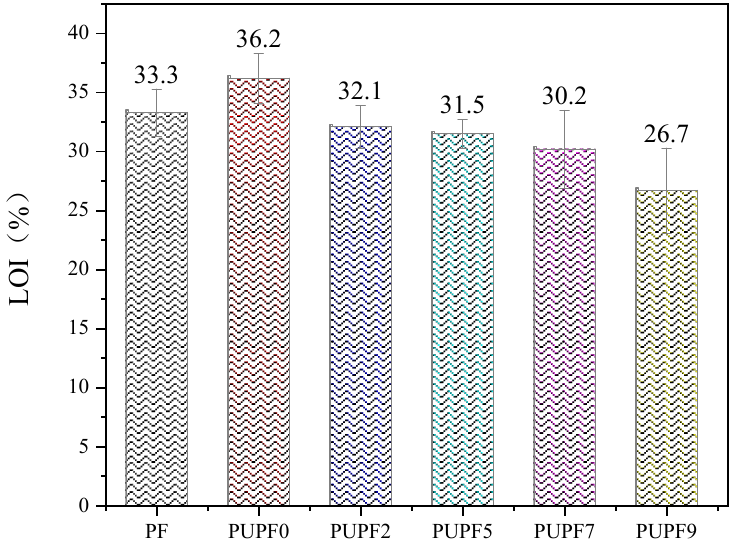
Figure 10. LOI of PF and PUPFs.